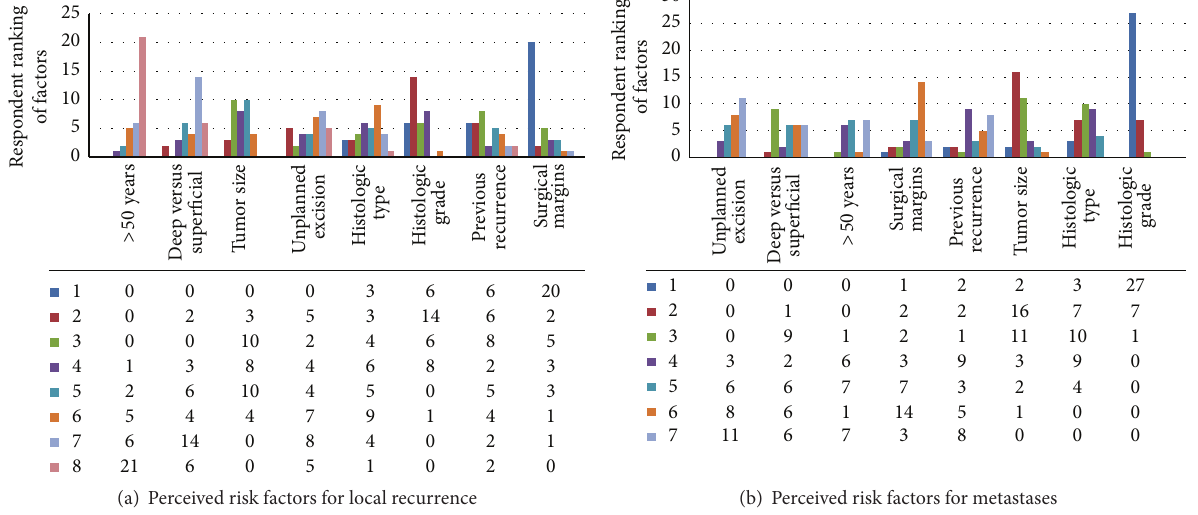
Figure 2: (a) Respondents were asked to rank 8 factors according to contribution to risk of local recurrence. The factor ranked 1 was perceived to most significantly increase risk of local recurrence. Of the 8 factors listed, respondents felt surgical margin was the factor that contributed most to local recurrence (20 ranked it as #1), followed by histologic grade. Age was the factor ranked lowest by survey participants (21 ranked it #8). (b) Respondents were asked to rank 8 factors according to contribution to risk of metastases. The factor ranked 1 was perceived to most significantly increase risk of metastasis. The most important risk factor for metastatic disease was felt to be histologic grade (27 respondents rankedit#1),followedbytumorsizeandhistologictype.Unplannedexcisionbeforereferralwasperceivedtocontributetheleasttosubsequent metastatic